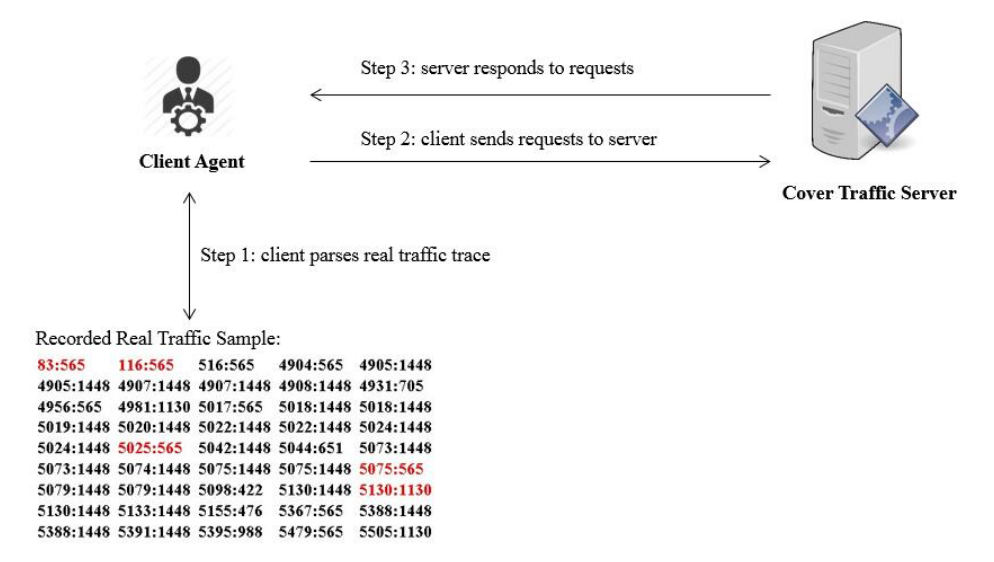
Figure 3. Cover traffic client and